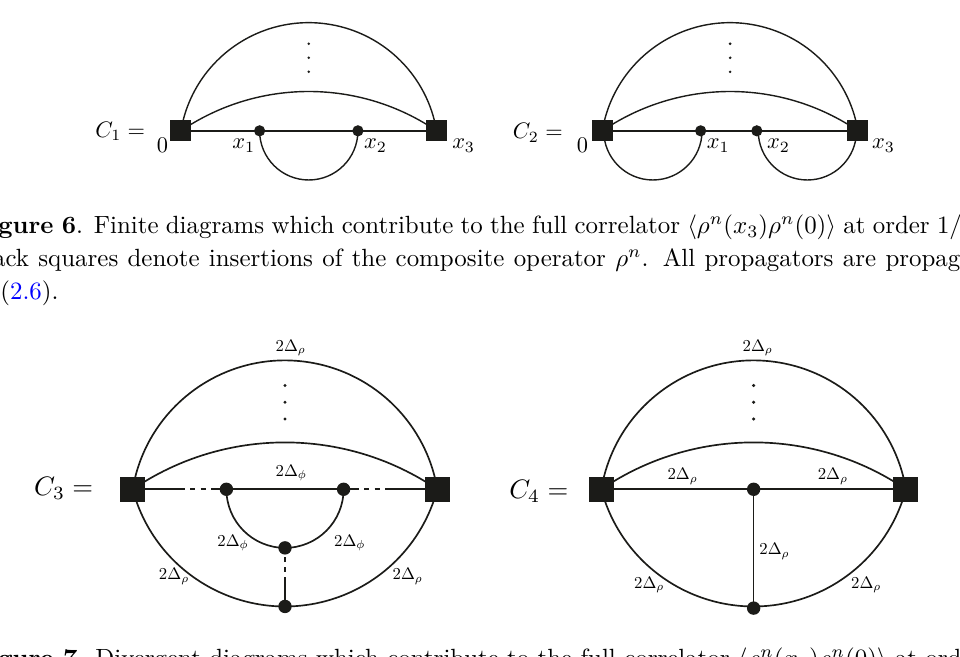
ρ n ( x 3 ) ρ n (0) at order 1 /N . h i